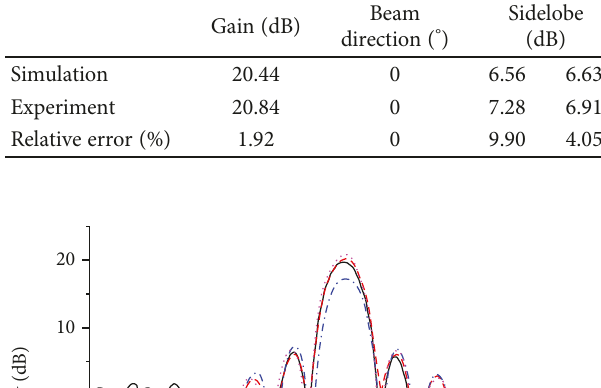
Figure 15: Electrical performance tester.